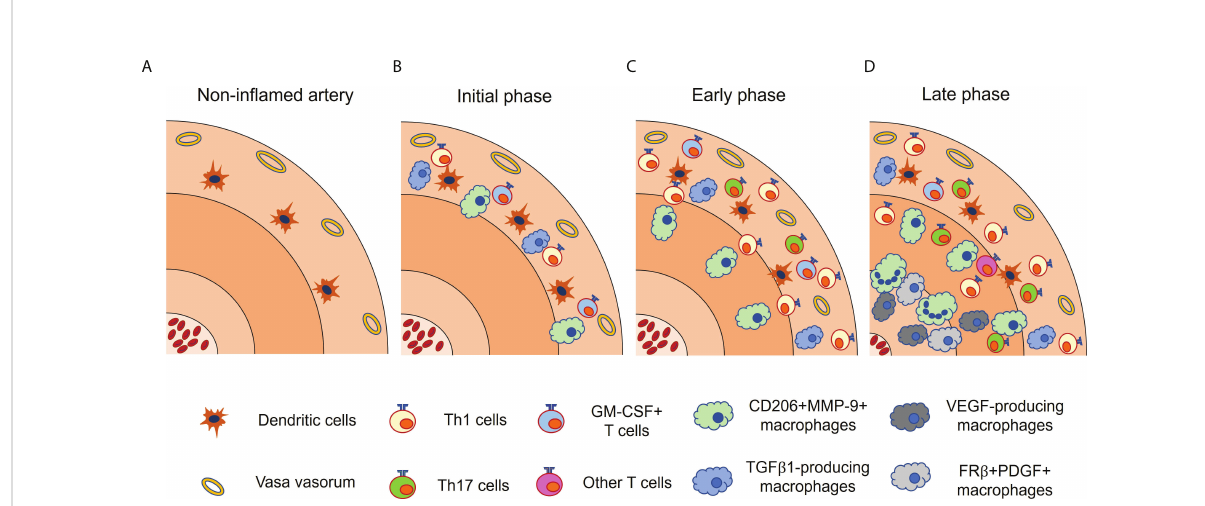
FIGURE 2 Functionally heterogenous macrophages in giant cell arteritis. Vascular lesion of giant cell arteritis contains a variety of macrophage subsets, each with a characteristic distribution. (A) In non-in fl amed artery, vascular dendritic cells (vasDCs) reside in the media-adventitial border. (B) In the initial phase, vasDCs initiate in fl ammatory cascade, and recruits T cells and monocytes through chemokines. In fi ltrated monocytes are differentiated into CD206+MMP-9+ macrophages by GM-CSF released from activated T cells. TGF b 1-producing macrophages are also present in the adventitia. (C) In the early phase, CD206+MMP-9+ macrophages migrate to the media and the media-intima border. Adventitial in fl ammation is increased. (D) In the late phase, CD206+MMP-9+ macrophages often fuse to form multinucleated giant cells and produce M- CSF, which gives rise to FR b + PDGF-producing macrophages at the media-intima border. Multiple cytokines and TLR2 are thought to be involved in the formation of multinucleated giant cells. VEGF-producing macrophages are preferentially located in the tunica media and intima. It should be noted that these macrophage subsets are not completely distinct. FR b , folate receptor b ; GM-CSF, granulocyte macrophage-colony stimulating factor; IFN, interferon; M-CSF, macrophage-colony stimulating factor; MMP, matrix metalloproteinase; PDGF, platelet-derived growth factor; TGF b 1, transforming growth factor b 1; VEGF, vascular endothelial growth